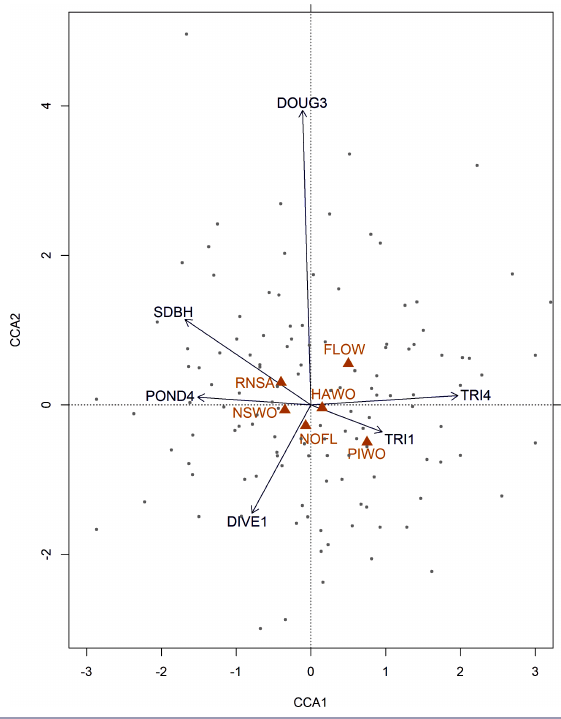
Fig. 3 . Distribution of cavity-nesting forest owl and woodpecker occurrence (triangles) along the first two axes of a canonical correspondence analysis (CCA) and the landcover, topographic, and snag characteristic variables with which they associated. Bird species are: (FLOW) Flammulated Owls, Psiloscops flammeolus ; (NSWO) Northern Saw-whet Owl, Aegolius acadicus ; (HAWO) Hairy Woodpecker, Picoides villosus ; (NOFL) Northern Flicker, Colaptes auratus ; (PIWO) Pileated Woodpecker, Dryocopus pileatus ; and (RNSA) Red- naped Sapsucker, Sphyrapicus nuchalis . Variables used to assess habitat associations were: (SDBH) diameter at breast height of snags, (POND4) ponderosa pine 0.4 km-scale, (TRI4, TRI1) terrain ruggedness index 0.4 and 1 km-scale, respectively, (DIVE1) landcover diversity 1 km-scale, and (DOUG3) Douglas-fir 3 km-scale, which combined explained 14% of the variation in the occurrence of this avian